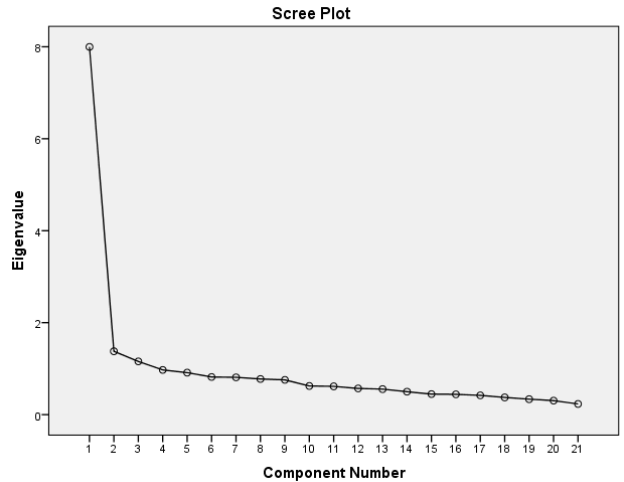
Figure 6. Scree plot of critical success factors for adoption of e-Procurement systems.